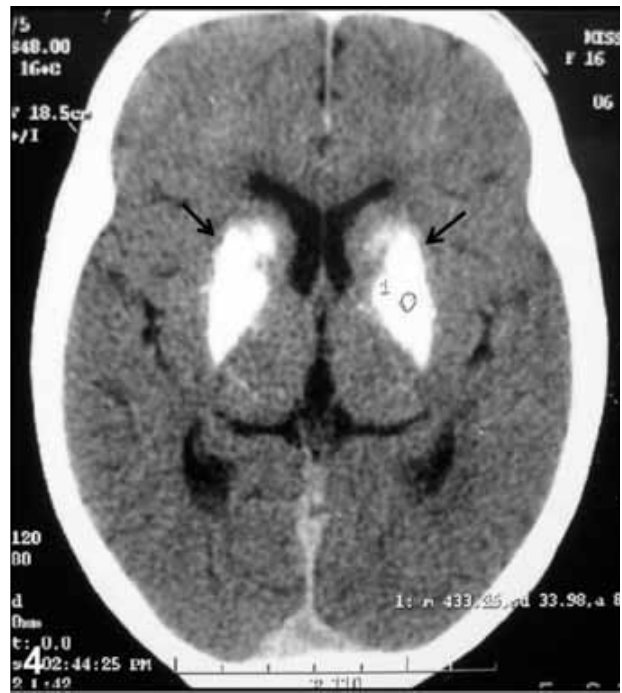
camptodactyly.Fig. 4. Non-contrast CT of the head shows dense bilateral basal ganglia calcification (black arrows).